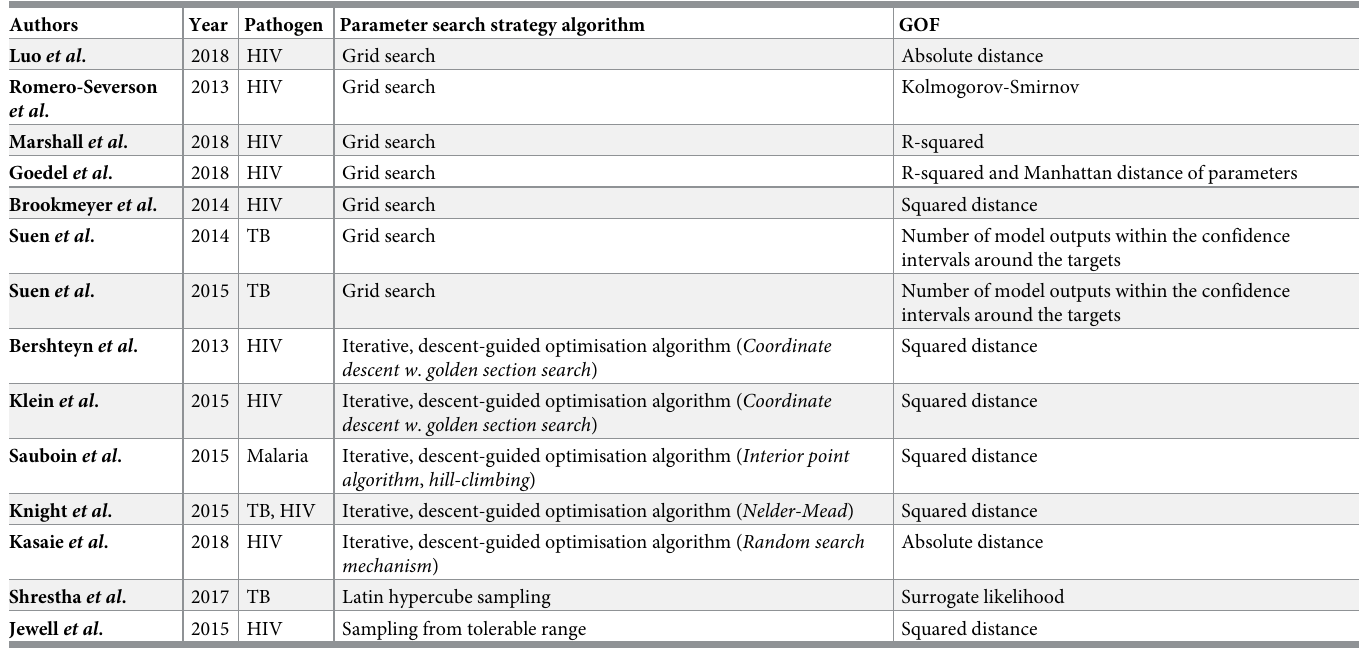
Table 1. Details of the calibration methods used in articles using optimisation algorithms for calibration, sorted by parameter search strategy